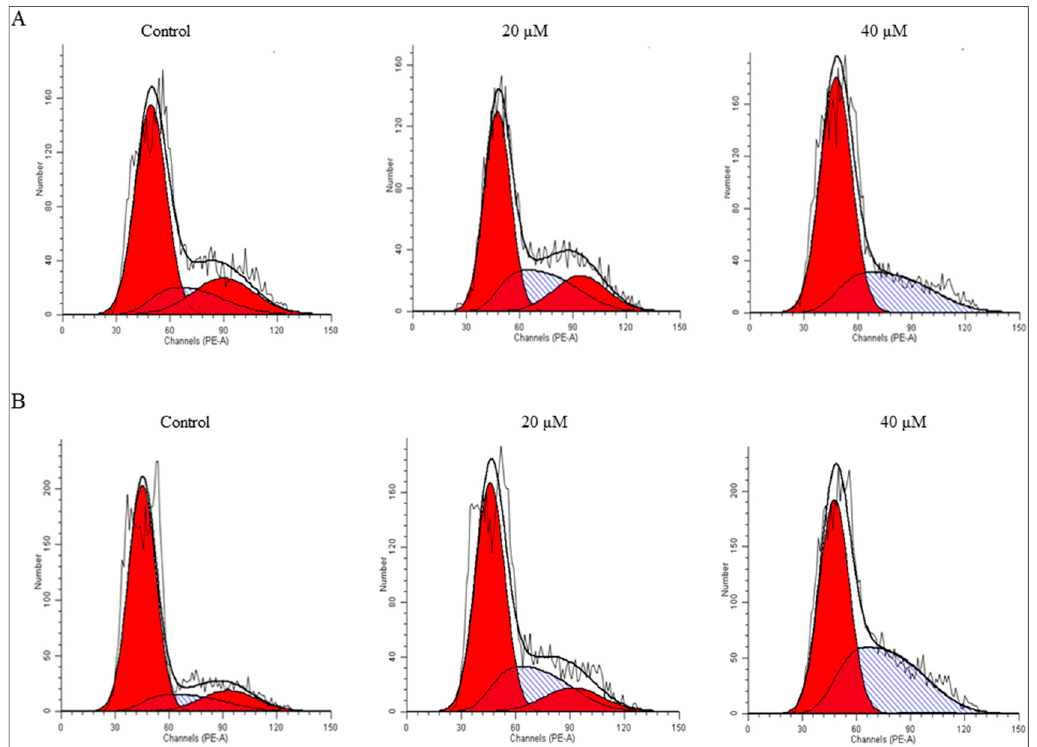
Figure2. Flow cytometry analysis of cell cycle phase distribution in DU145 cells: ( A ) DU145 cells treated with 20 and 40 µM of altholactone for 24 h; ( B ) DU145 cells treated with 20 and 40 µM of altholactone for 48 h. Data are representative of three independent experiments ( n = 3).